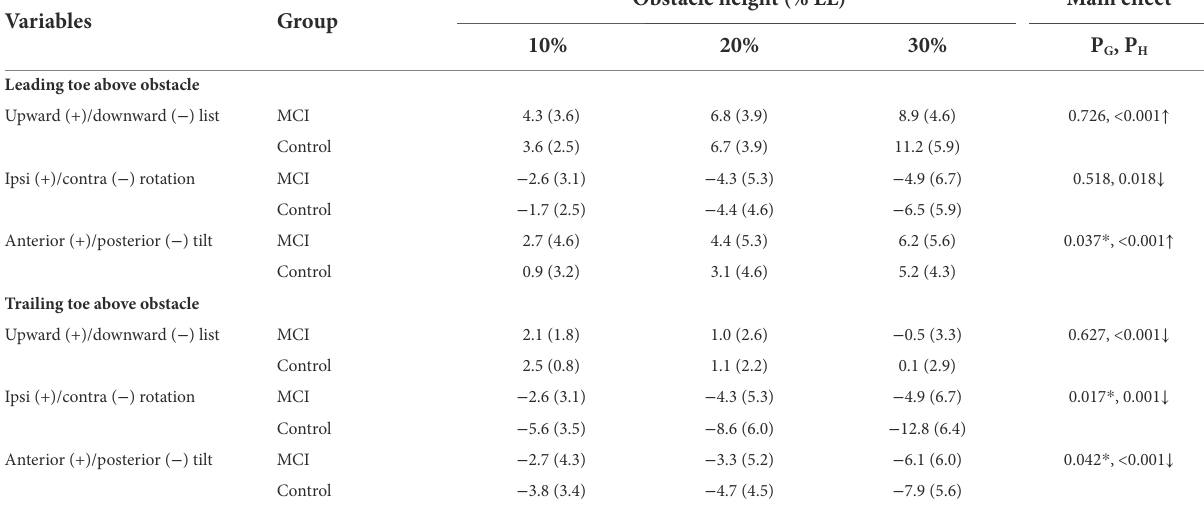
TABLE 3 Means (standard deviations) of the crossing angles of the pelvis relative to the global norm in patients with mild cognitive impairment (MCI) and healthy controls (Control) when the leading or trailing toe was above the obstacles of heights of 10, 20, and 30% of the subjects’ leg length